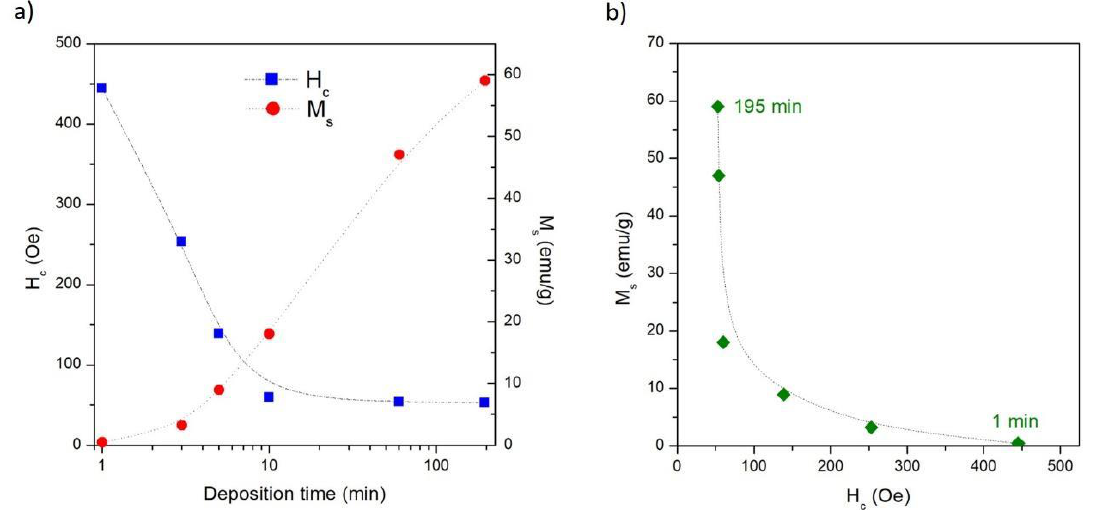
Figure 9. ( a ) Evolution of coercive field (H c ) and saturation magnetization (M s ) as a function of electrodeposition time; ( b ) saturation magnetization (M s ) as a function of coercive field (H c ) for all studied hybrid Co/NPG heterostructures. The dashed lines are only a guide for eyes.